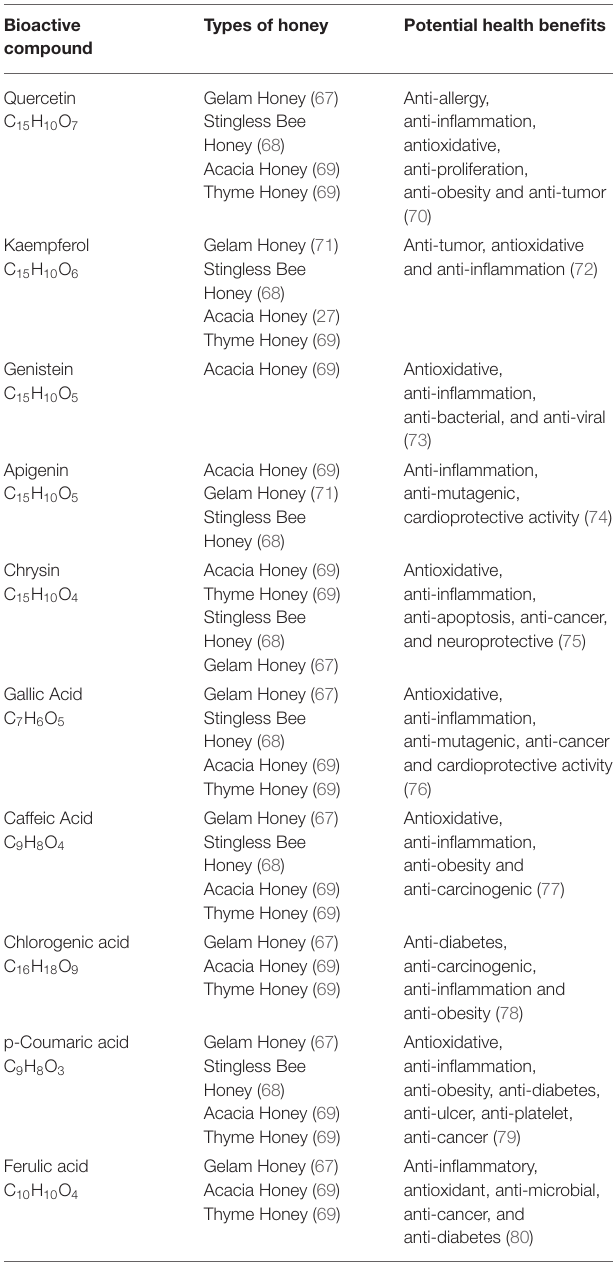
TABLE 2 | Common phenolic acids and flavonoids found in different types of honey. Bioactive